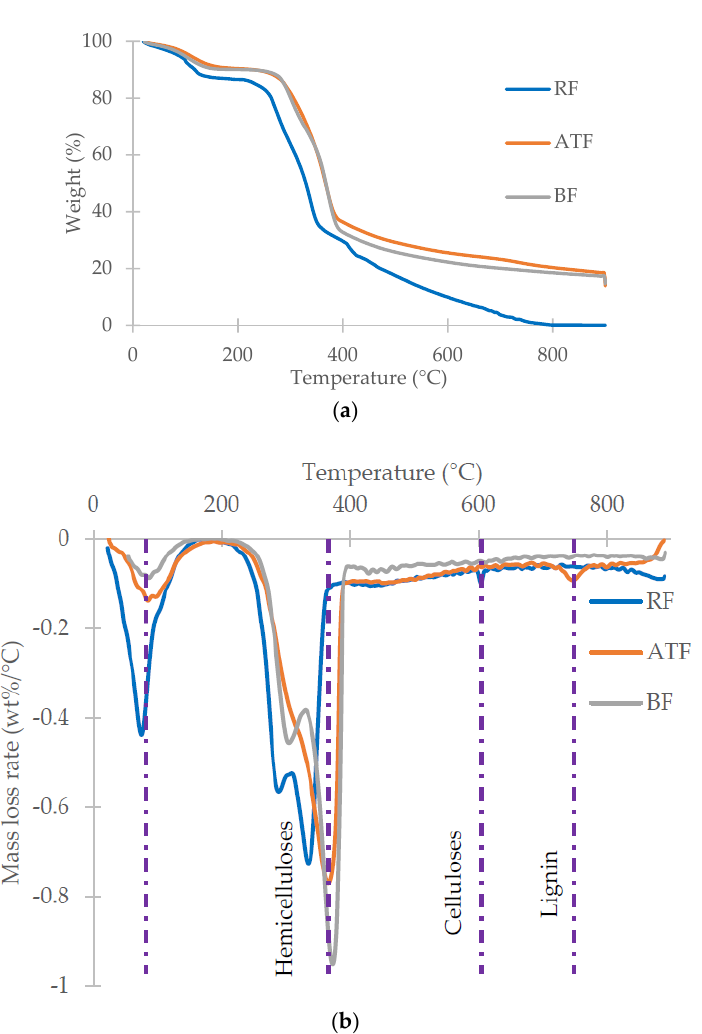
Figure 12. Thermal gravimetric of fibers tested: ( a ) thermogravimetric analysis (TGA); ( b ) differential thermal analysis (DTA). Table 6. Thermal gravimetric data results of coconut